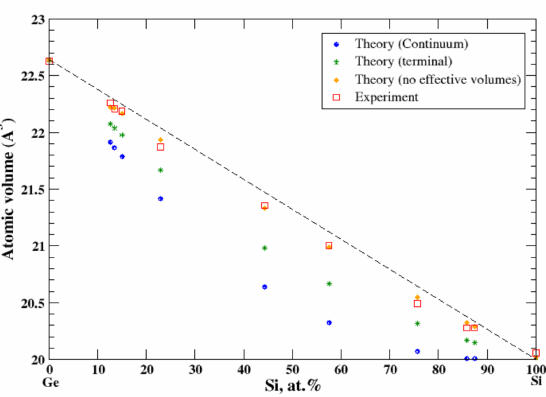
Figure 18. Atomic volume vs. concentration for Ge-Si alloy system. The experimental data are from Ref. [16] (p. 679).